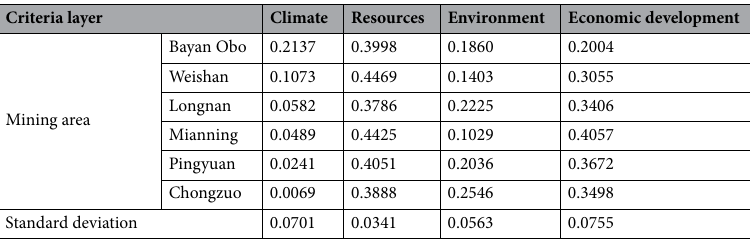
Table 5. Obstacle degree and standard deviation of each mine